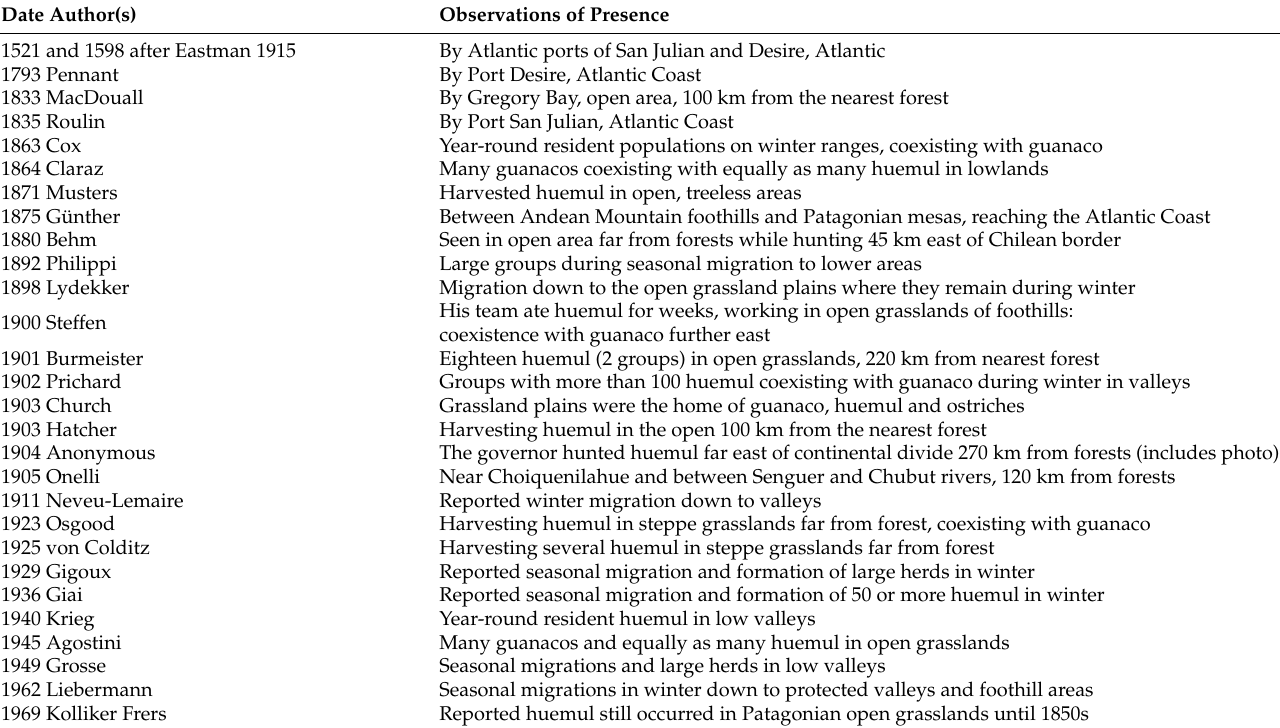
Table 1. Selection of historical reports about huemul: distribution between the Andean Mountains and the Atlantic Ocean, coexistence with guanaco, group sizes, migratory-resident behavior, and